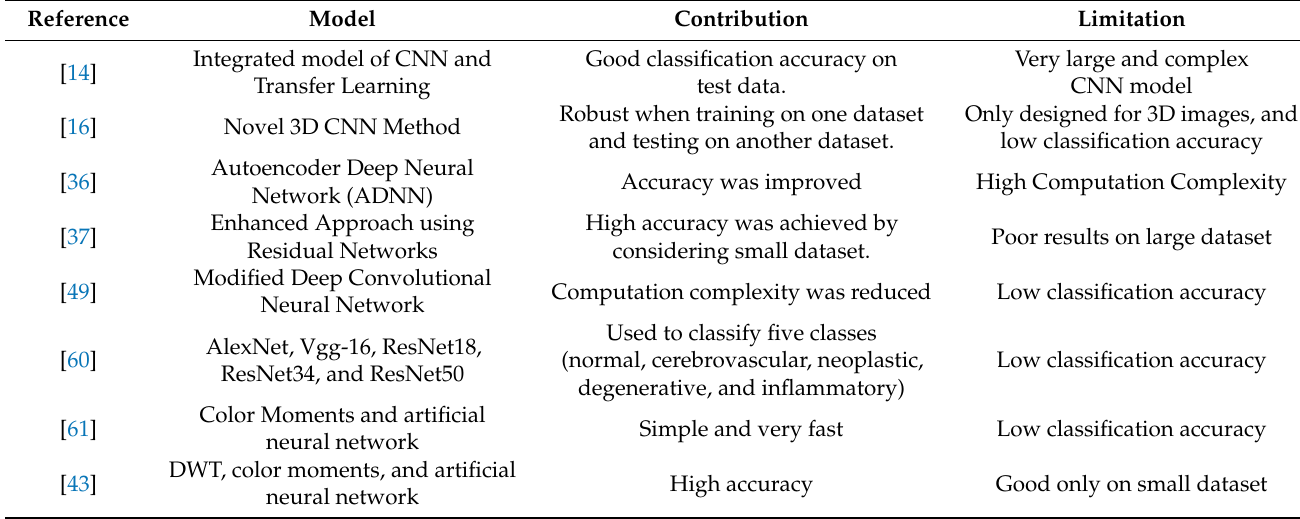
Table 2. Different models with their strengths and